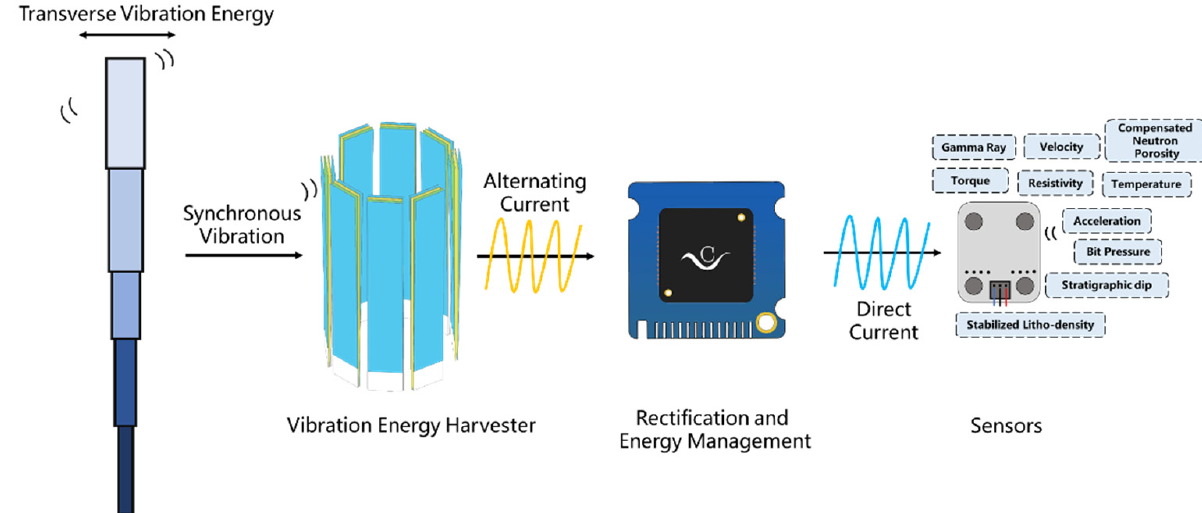
Figure 1. The concept diagram of this work.